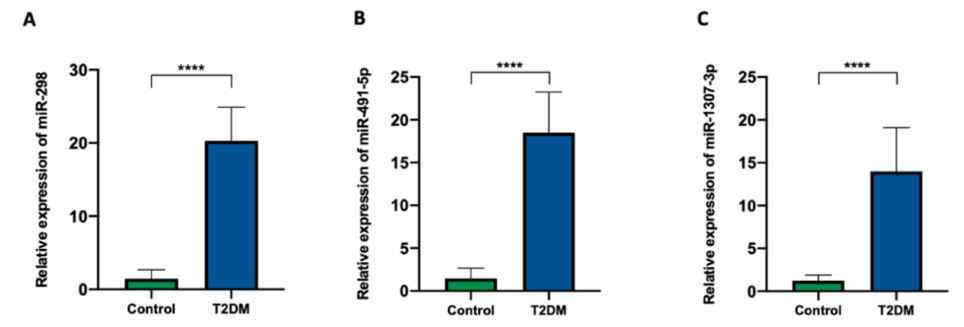
Figure 6. Relative mRNA expressions of the di ff erent miRNAs in the serum samples. ( A ) miR-298; ( B )miR-491-5p; ( C )miR-1307-3p. EachbarrepresentsthemeanratioofgeneexpressionandmiR-103a-3p and miR-16-5p ± standard error of the mean (SEM). Asterisks indicate a significant di ff erence compared to the control (**** p ≤